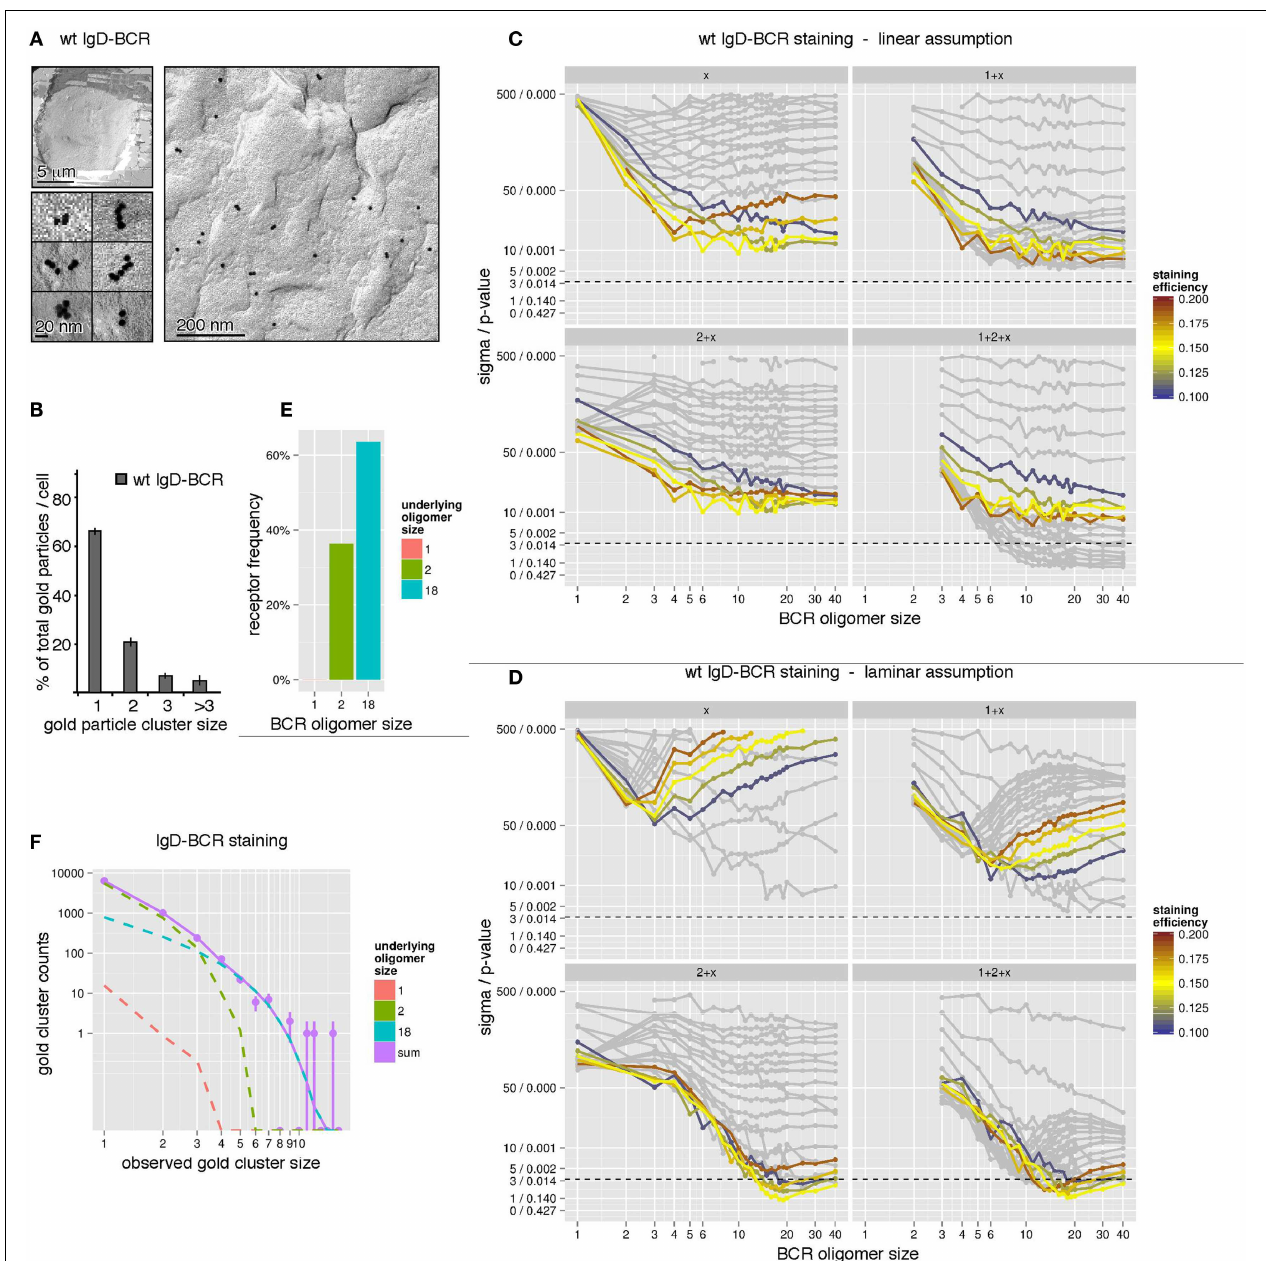
namely “one BCR oligomer size only” ( x , upper left panel), “BCR monomers + another single BCR oligomer size” (1 + x , upper right panel), “BCR dimers + another single BCR oligomer size” (2 + x , lower left panel), and “BCR monomers, dimers + another single BCR oligomer size” (1 + 2 + x , lower right panel). Models are rejected above the dashed line corresponding to a p -value of 0.01. (D) The observed gold particle cluster size distribution was simulated as in (C) with the assumption of an underlying laminar BCR oligomer geometry. (E) Our simulations predict that 60% of all receptors are part of oligomers of size 18 in a laminar geometry and 40% are BCR dimers. (F) Gold cluster counts (dots with error bars) compared to the prediction of best fitting model (continuous line).The number of counts originating from the different underlying BCR oligomer sizes are shown as dashed lines, indicating that observed clusters up to a size of 3 are primarily caused by BCR dimers, while gold clusters larger than 3 can be explained by BCR clusters of size 18.The impact of BCR monomers is